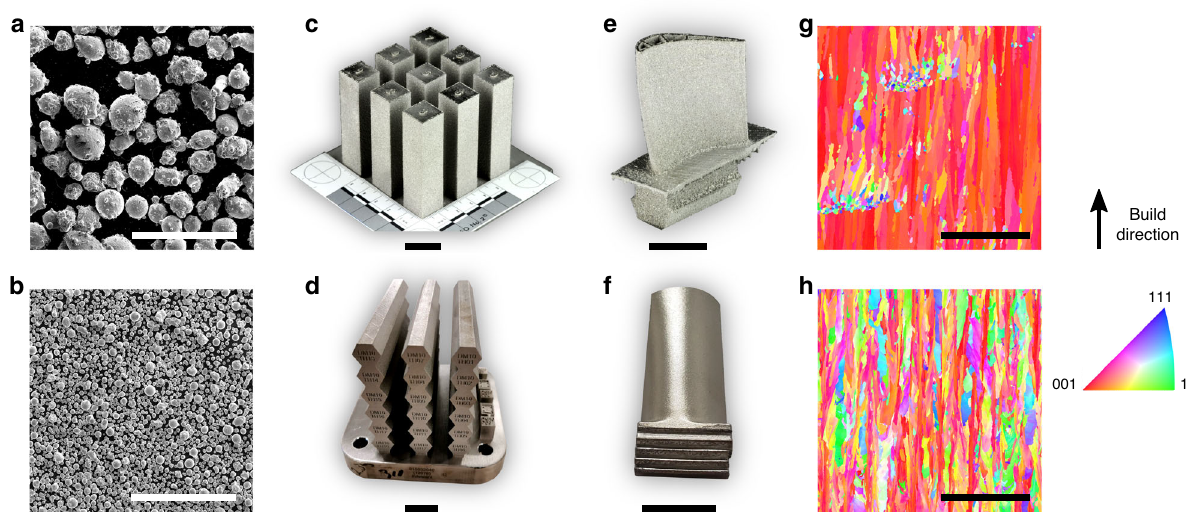
Fig. 1 Additive manufacturing of a CoNi-base superalloy through EBM and SLM. SEM micrographs of metal powder of SB-CoNi-10 used for a EBM and b SLM printing trials. Simple bar geometries have been printed for uniaxial tensile testing c , d in addition to complex geometries such as prototype turbine blades with e internal cooling channels or f thin, over-hanging platforms. IPF maps acquired through EBSD show the grain structure of the as-printed CoNi- base superalloy along the build direction manufactured through g EBM and h SLM. The scale bars for a , b and g , h are 500 μ m. The scale bars for c – f are 2 cm.